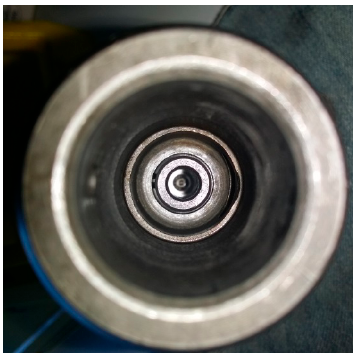
Figure 22. Closer view of the New Diesel pump’s stuck plunger.